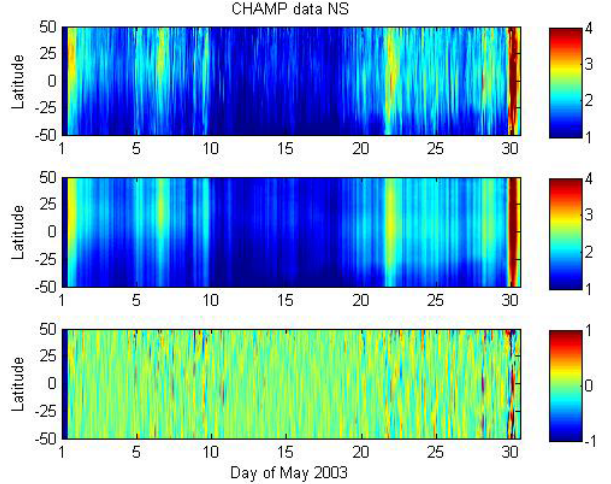
Fig. 4b. Same as Fig. 4a for the SN orbit segments. In this case LT at the satellite position varies from 05:40 p.m. to 02:55 p.m. (see Fig.